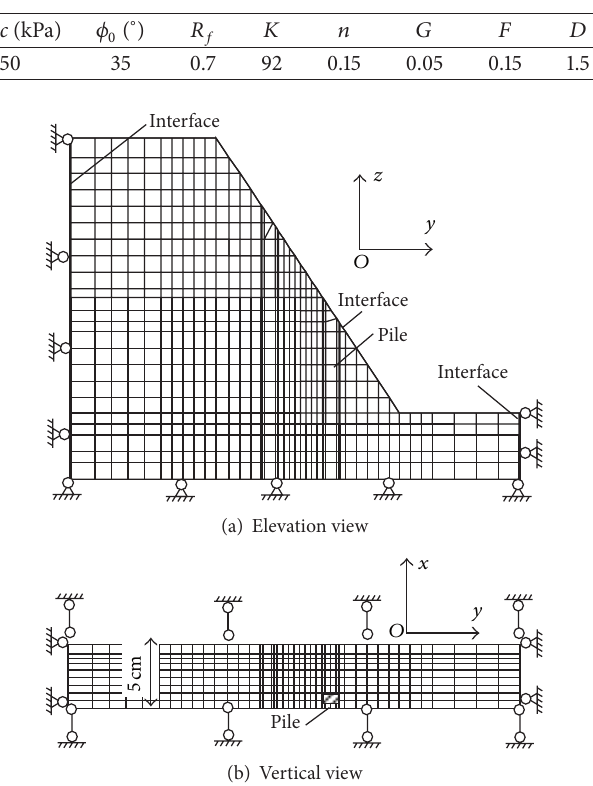
Figure 3: Mesh and boundary of the slope for numerical